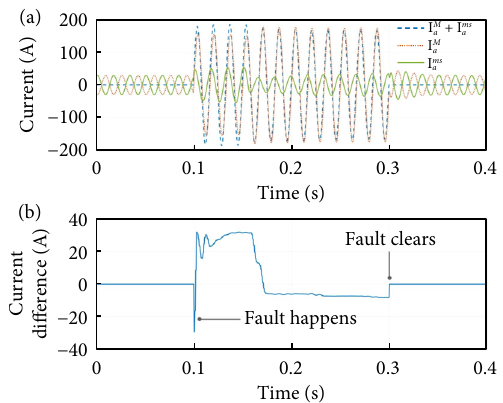
Fig. 9 Results for single-phase-to-ground faults with optimization-based AFM. ( a ) phase currents at the fault location.